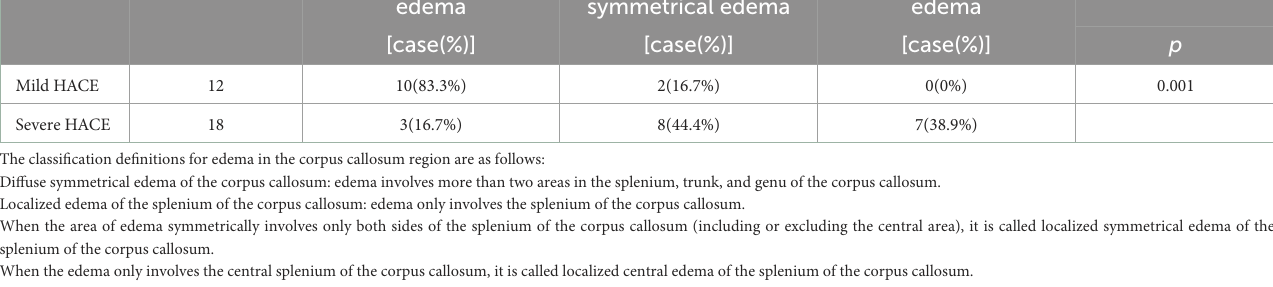
TABLE 7 Distribution of edema in the corpus callosum in 30 cases of HACE.